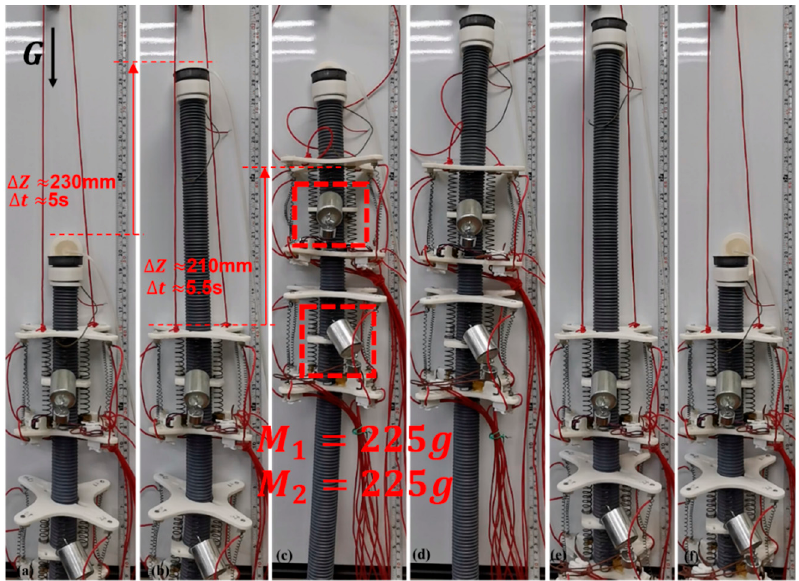
Figure 18. Two-module prototype load of 450 g (heavy object). ( a – f ) represents the motion of the robot.